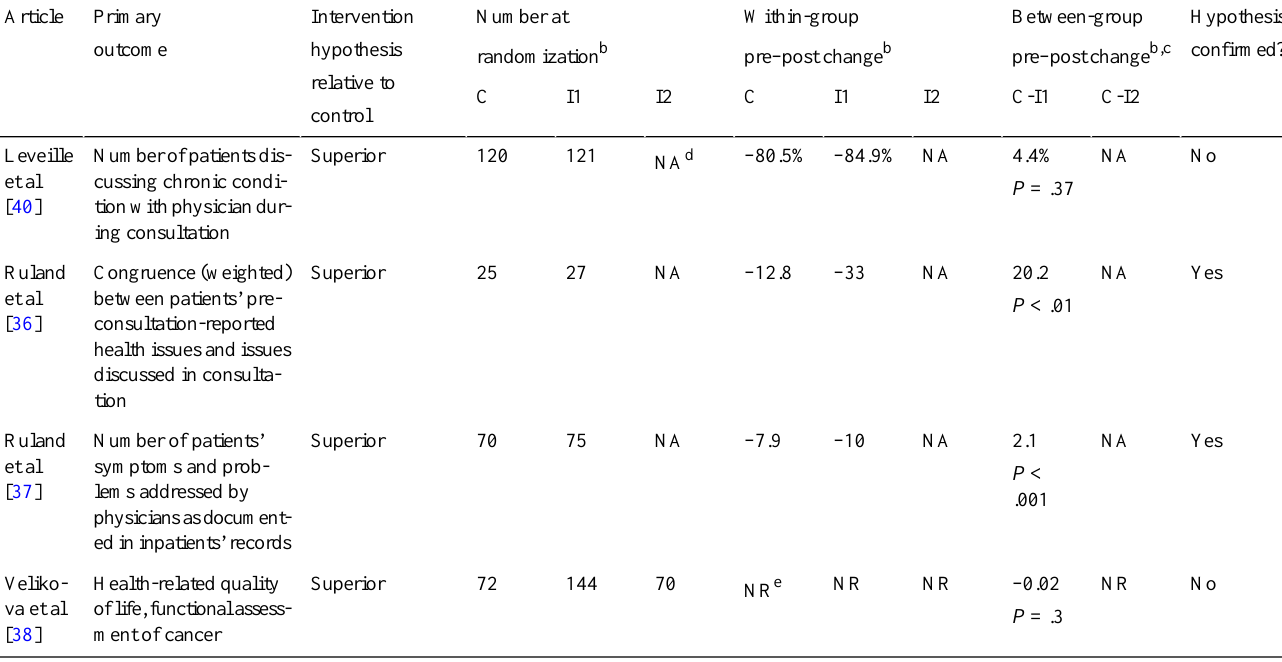
Table 2. Effects reported in consultation support randomized controlled trials of acceptable quality of electronic symptom reporting, in alphabetic order of first author a